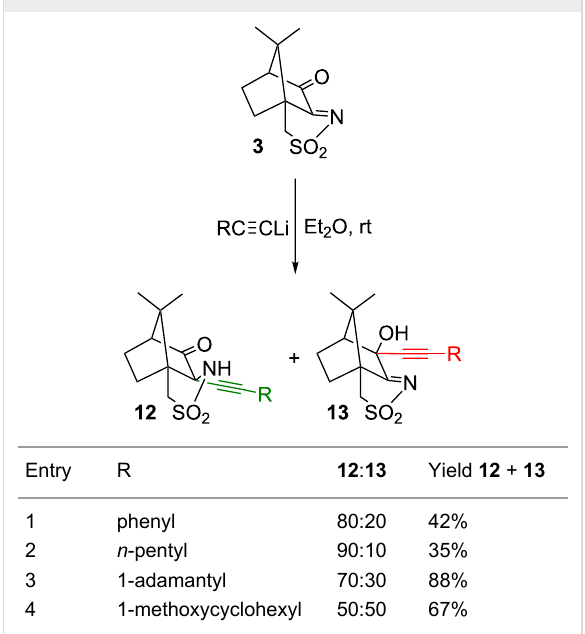
Table 1: Selectivity in the reaction of oxoimide 3 with alkynyllithium